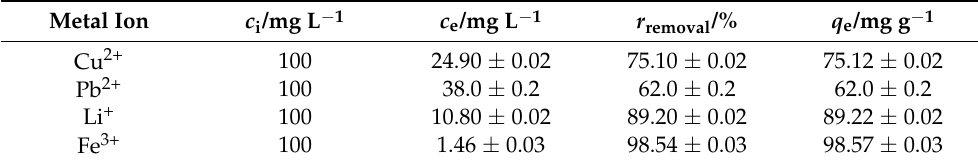
Table 2. Removal percentages ( r removal ) and adsorption capacities ( q e ) of poly(AH)Na for metal ions.